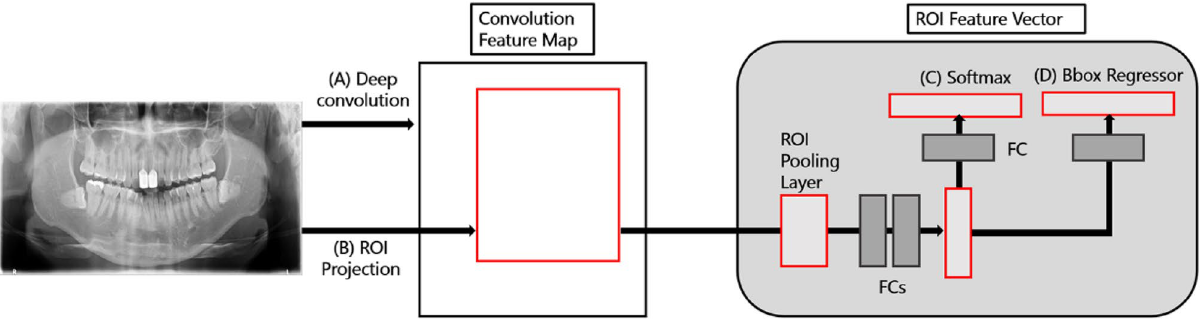
Figure 1. Fast RCNN network model for predicting soft tissue calcification. (A) Deep convolution suggested candidate. (B) Candidate boxes are executed in Pooling Layer. (C) Softmax determines class name of disease. (D) Regressor estimates probability index for each ROI